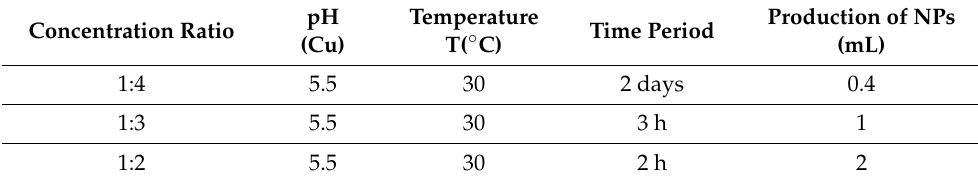
Figure 3. A schematic representation of formation, settlement and collection of CuNPs obtained from Fortunella margarita leaves’ extract. Table 1. Production of CuNPs at constant pH and temperature with variable concentration